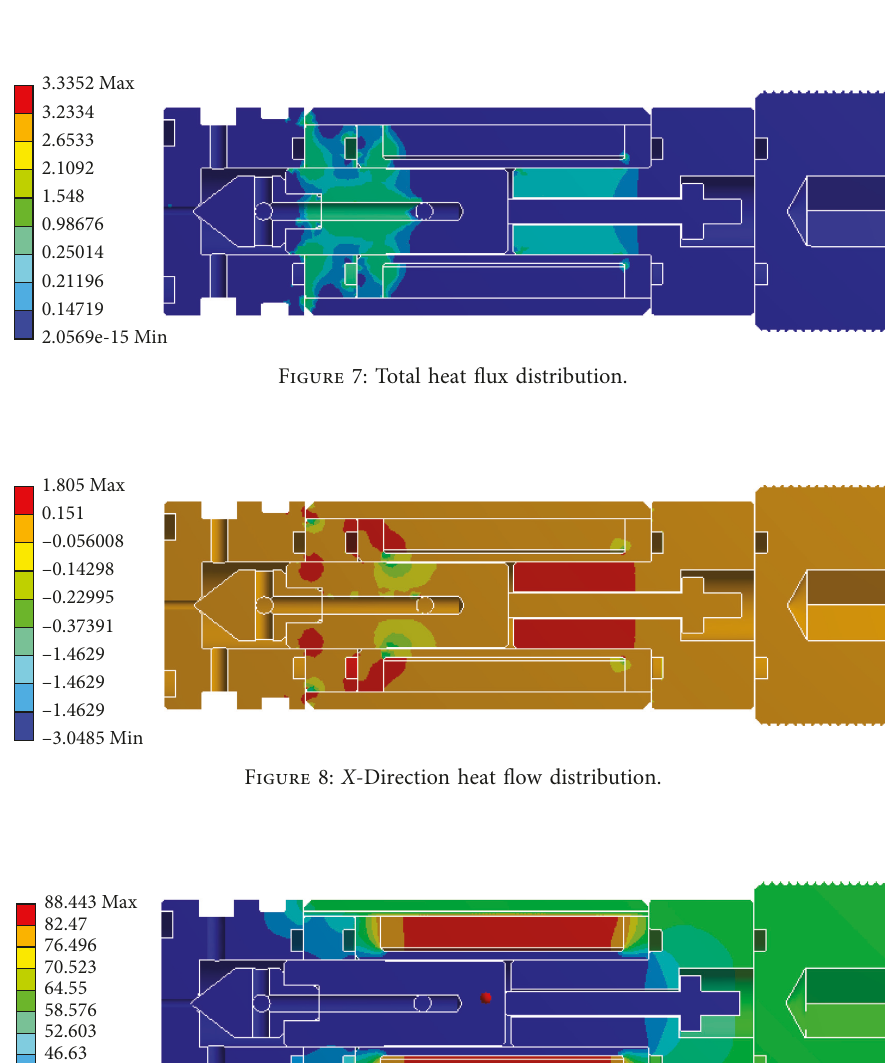
Figure 6: Temperature field distribution.